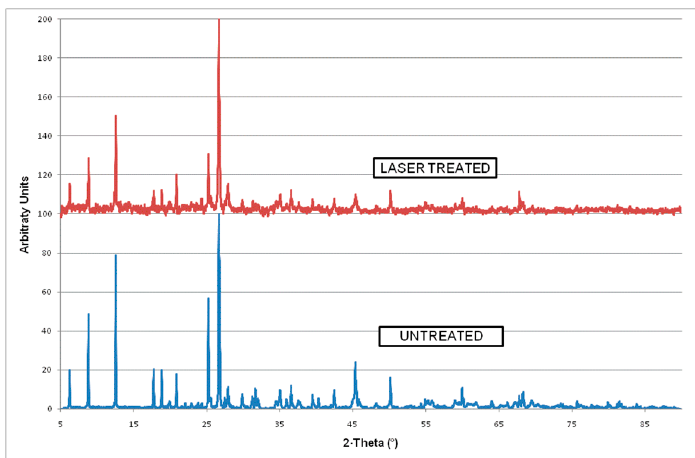
Figure 6. X-Ray Diffraction analysis of the laser-treated (resolidified material) and the untreated (or base) material.